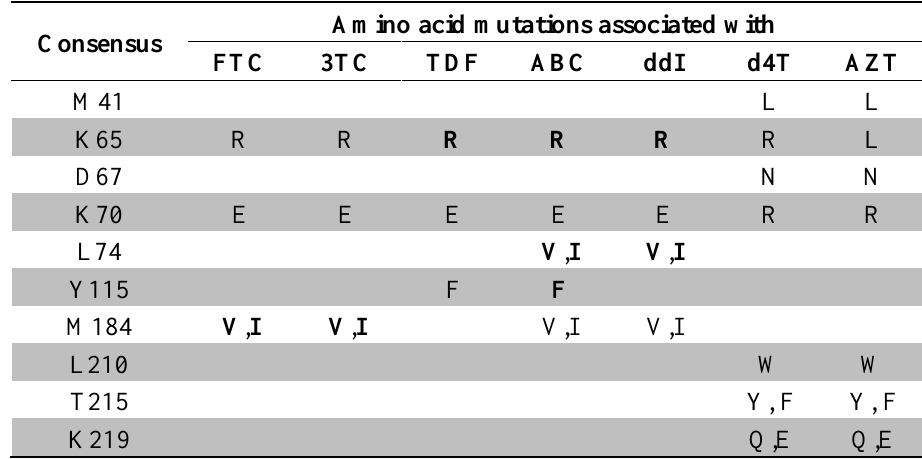
Table 1. Major NRTI Resistance